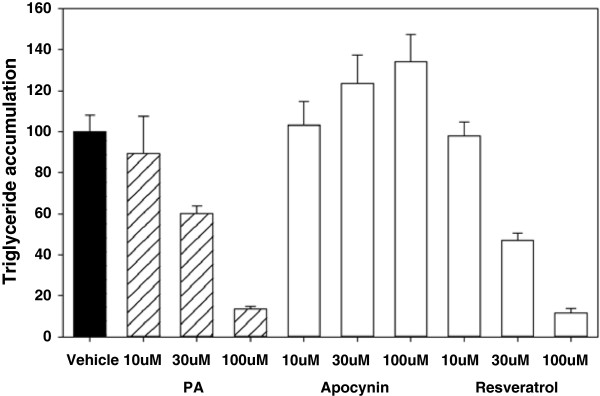
Effect of PA on adipocyte differentiation. Inhibition of human subcutaneous preadipocyte differentiation by PA. Differentiation was determined by the amount of lipid accumulation measured by total triglyceride. Data are expressed as a percentage of the control value. Values are mean ± standard error of the mean (SEM; n = 3).